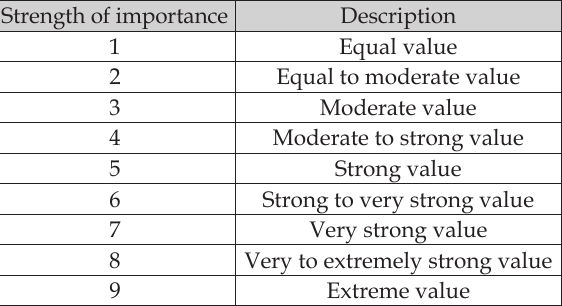
Table 1. Preference value